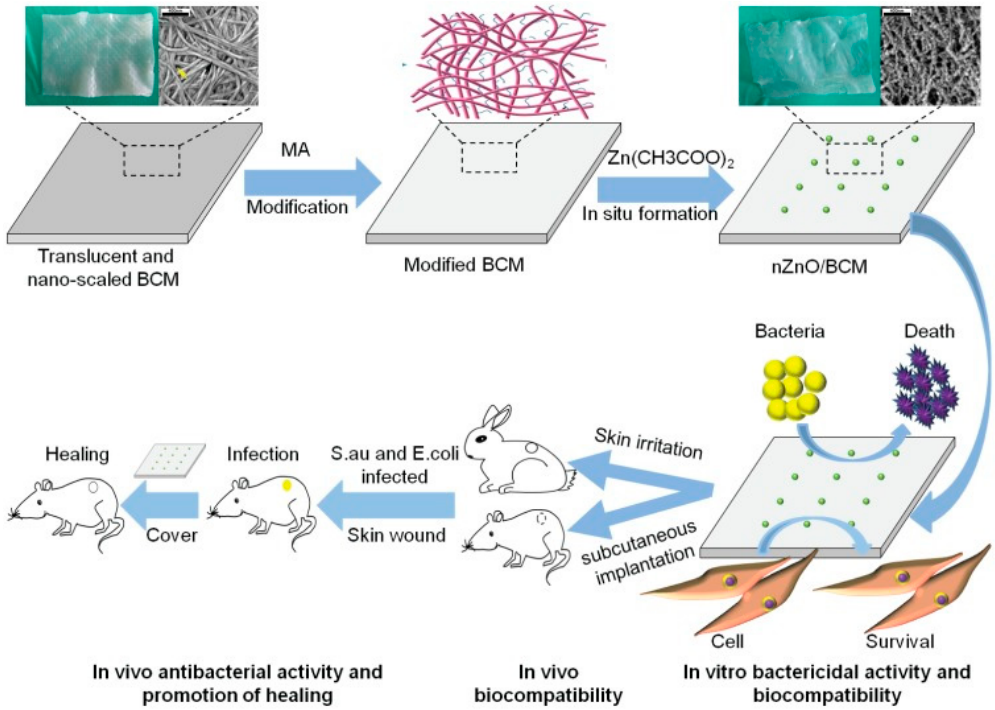
Figure 4. Schematic representation of the synthesis procedure and biological activity of the BCM/ZnO hybrids [40].